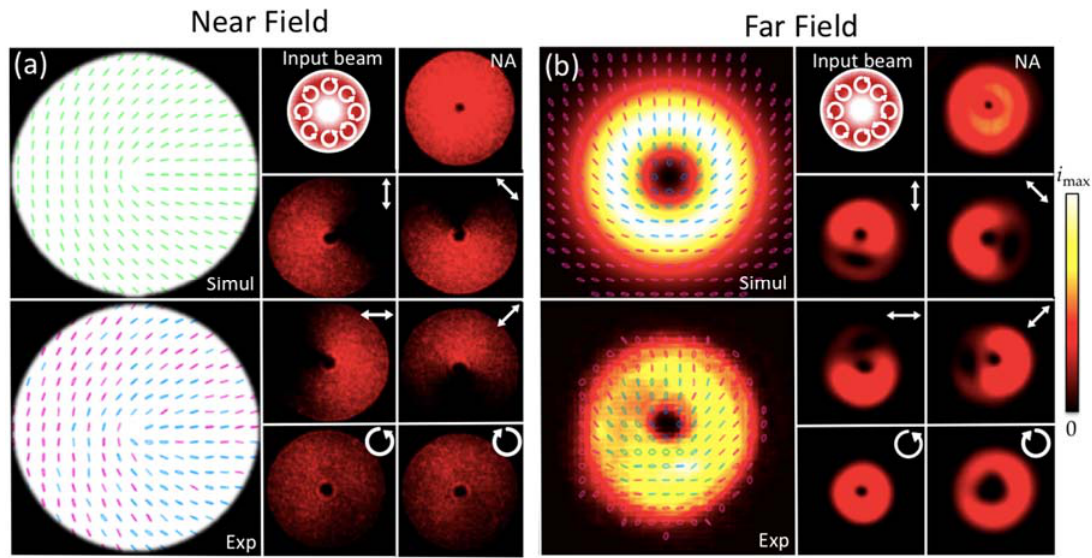
Figure 4. Results for the QW q-plate illuminated with an RCP vortex beam with (cid:96) = 2. ( a ) Results in the near field; ( b ) results in the far field. Simulated and experimental polarization maps, with equivalent color representation as in Figure 3. Experimental images captured for different orientations of the analyzer, indicated as white arrows (NA indicates no analyzer).